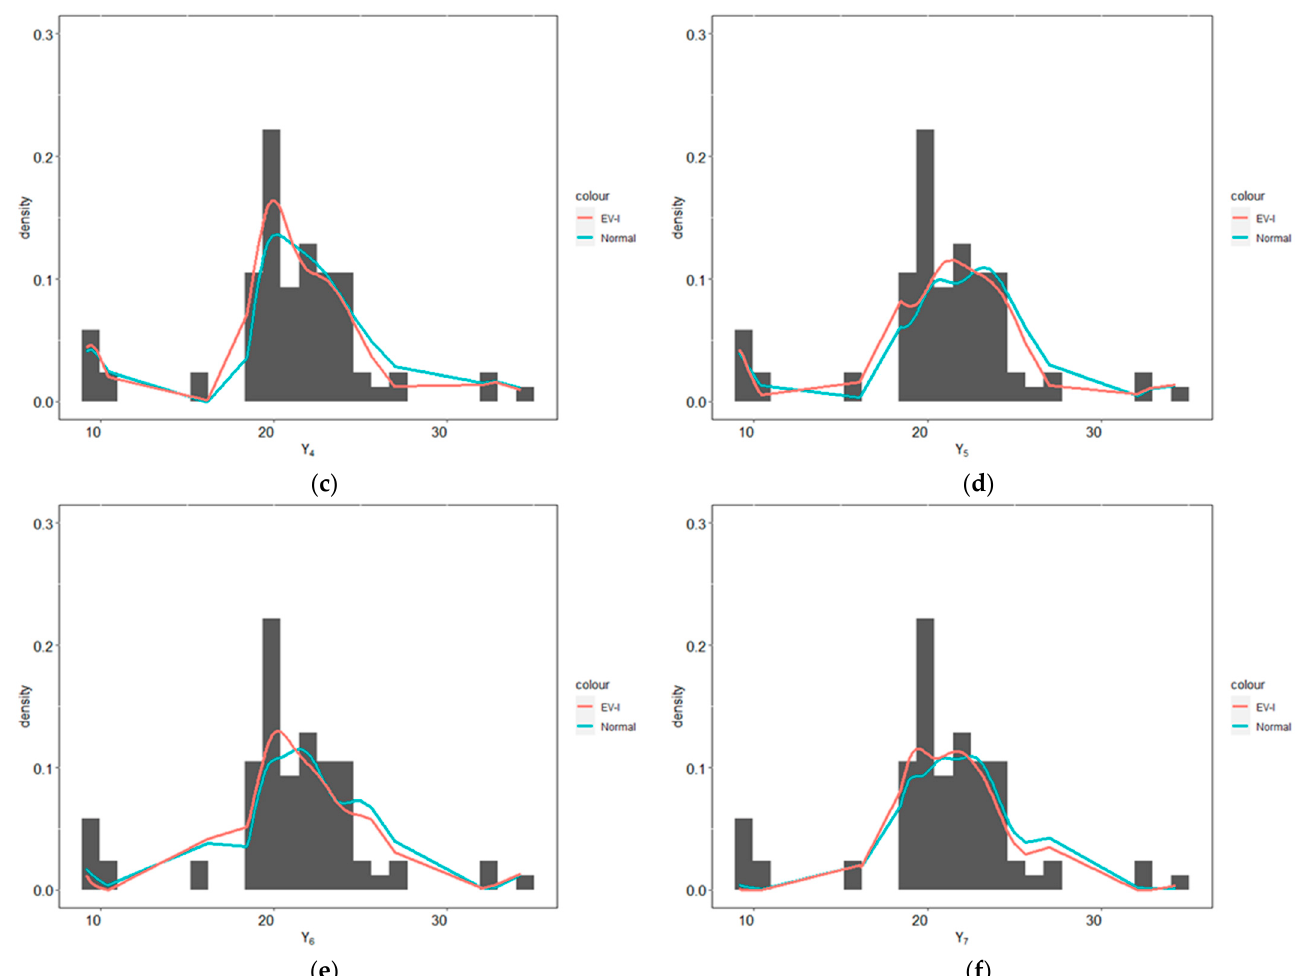
Figure 8. Predictive densities for galaxy data using the EV-I mixture and the Gaussian mixture distributions with ( a ) two components, ( b ) three components, ( c ) four components, ( d ) five components, ( e ) six components, and ( f ) seven components. Table 7. Comparison of Kullback–Leibler divergence using EV-I mixture and Gaussian mixture distributions for enzyme, acidity, and galaxy datasets.